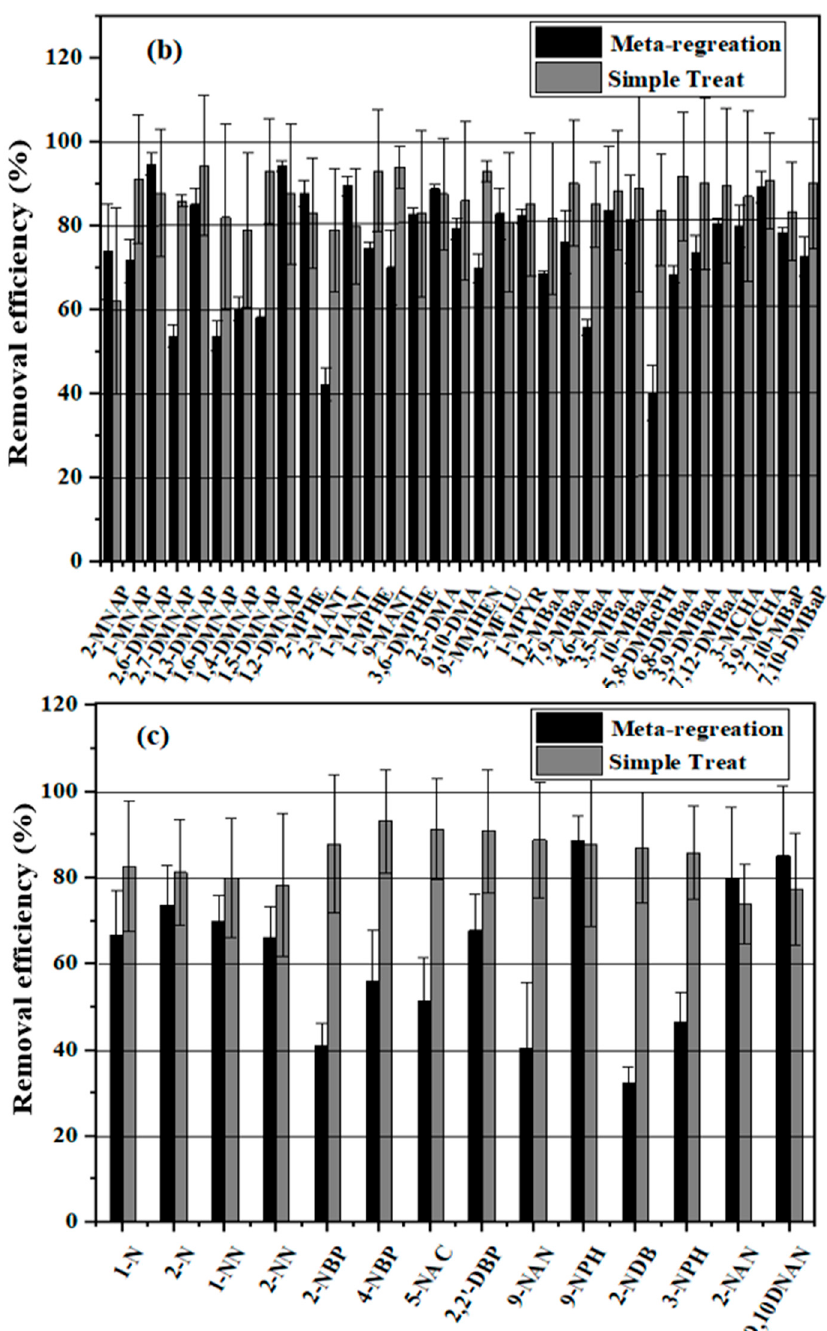
Figure 2. The removal efficiency of PAHs ( a ), Me-PAHs ( b ), and NPAHs ( c ) at 10 WWTP, prediction by Simple Treat 4.0 and meta-regression (mean ± SD).